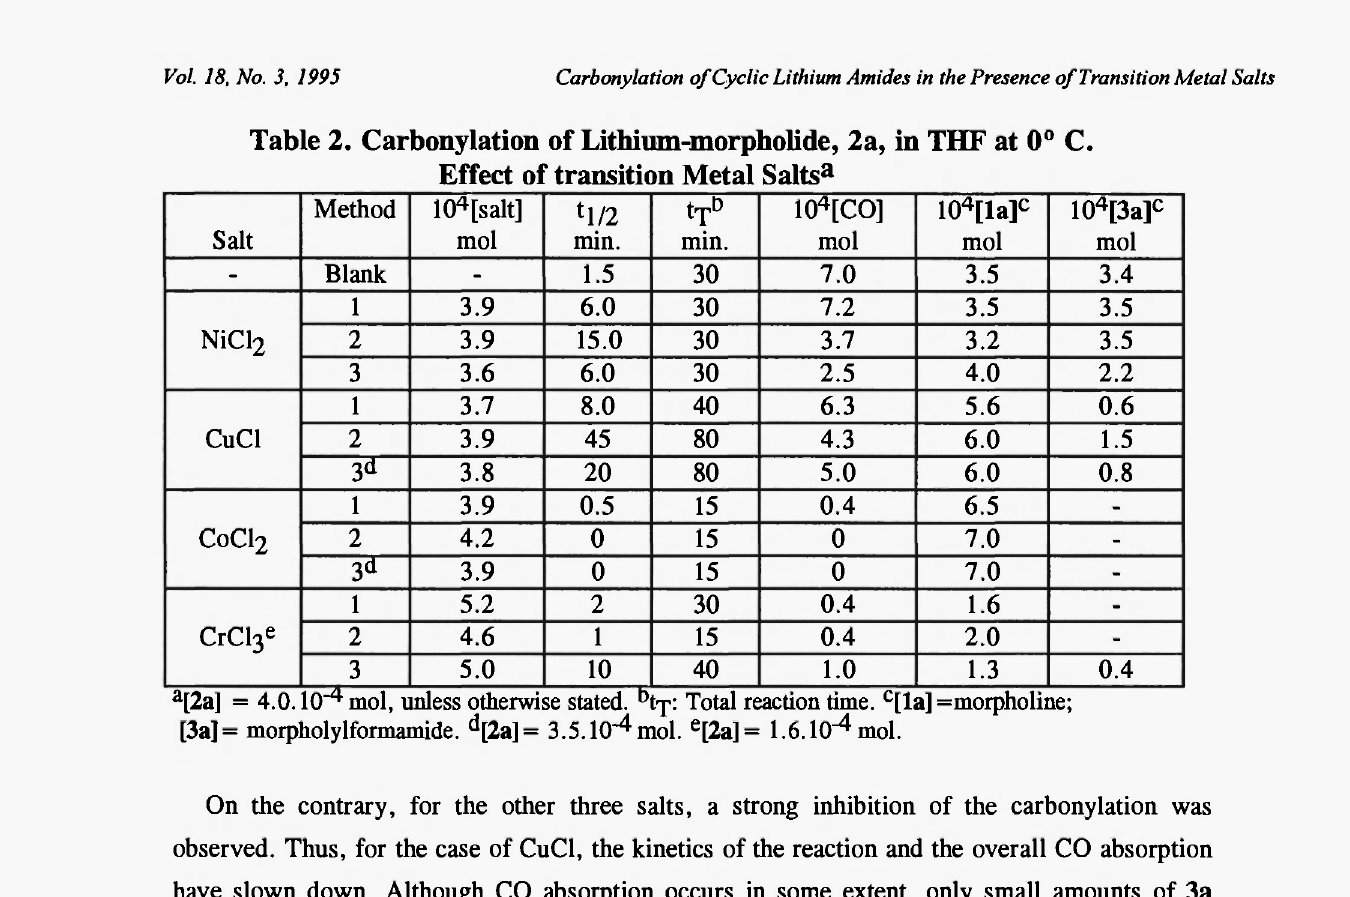
Table 2. Carbonylation of Lithium-morpholide, 2a, in THF at 0°